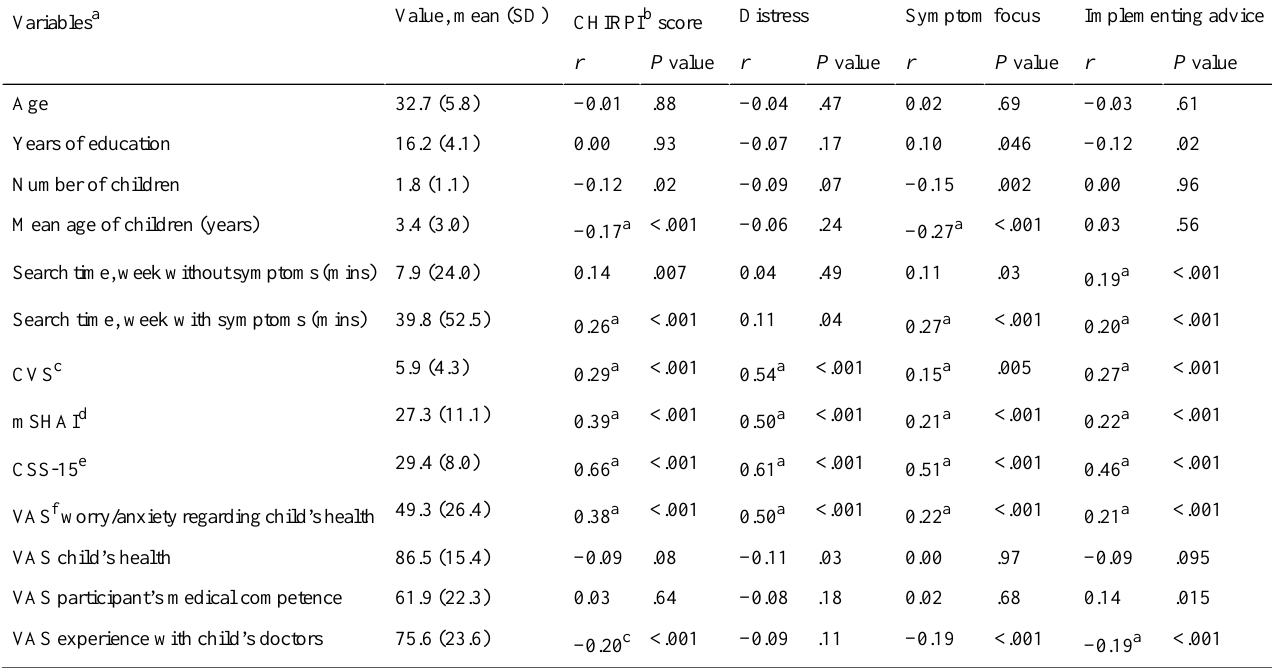
Table 4. Correlations between the full scale or subscales and demographic variables, time spent searching the internet for information related to one’s children’s health, health-related questionnaires, and the visual analog